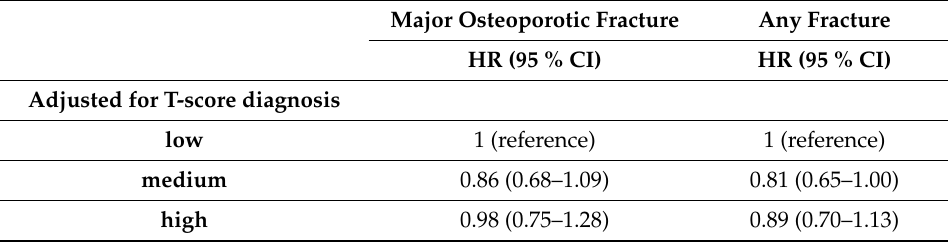
Significant results are in